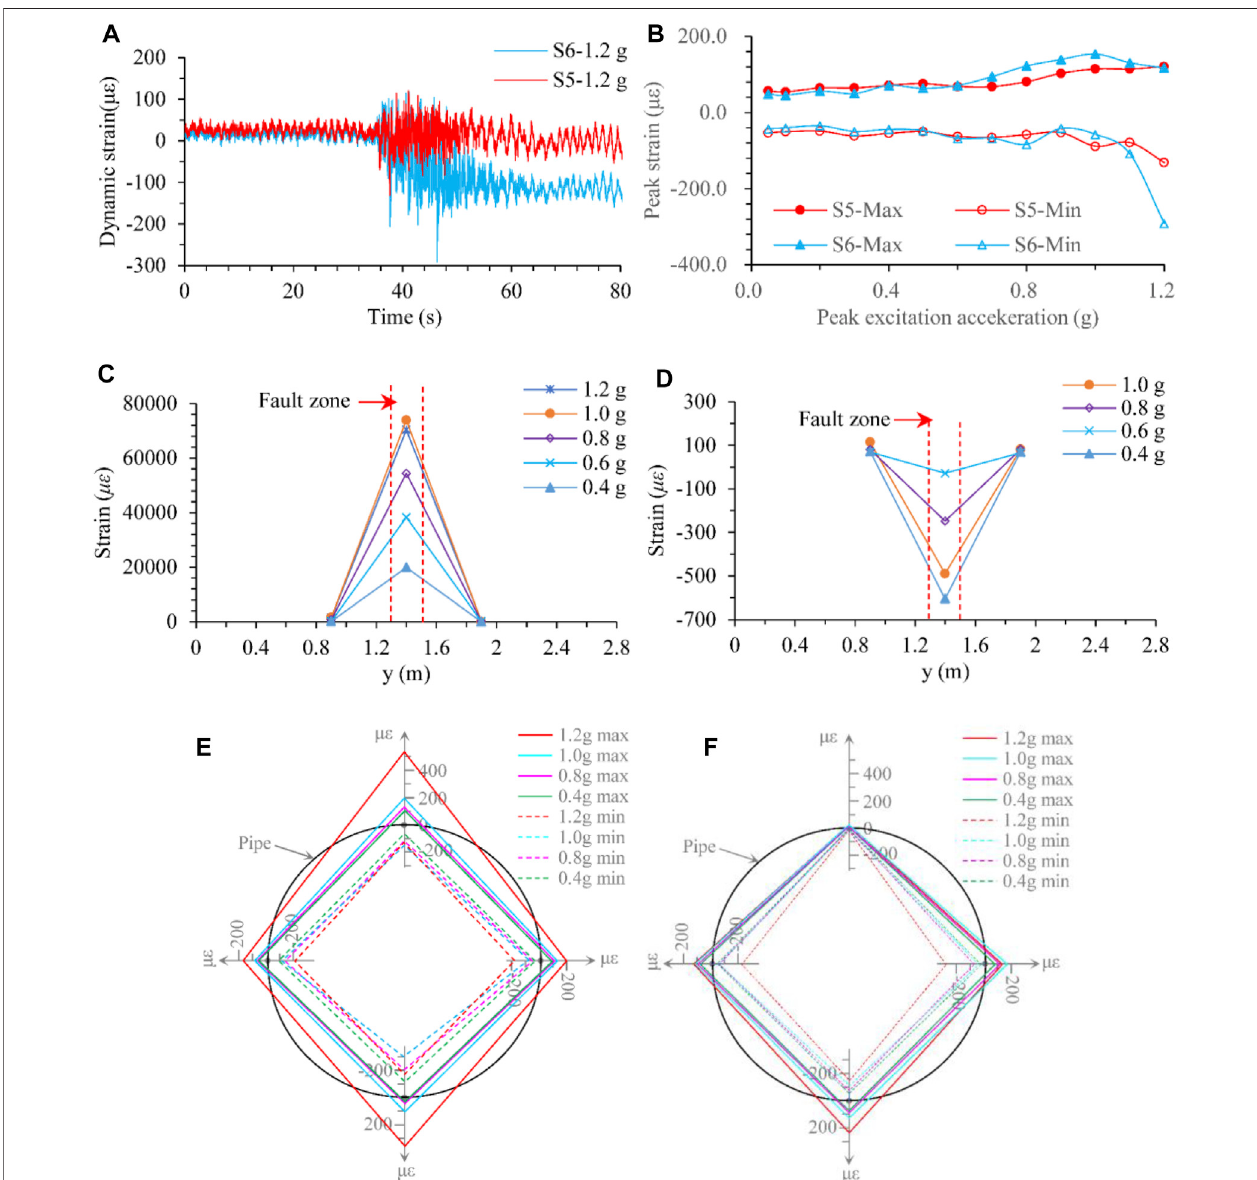
FIGURE 18 | Responsive dynamic strain of the pipe. (A) Strain time-history curves of typical monitoring points, (B) peak of responsive strain versus excitation acceleration, (C) peakaxialstrainvariationalongthepipebottom, (D) peakaxialstrainvariationalongthepipeside, (E) peakcircumferentialstrainalongthecross-section of y (cid:1) 1.4 m, (F) peak circumferential strain along the cross-section of y (cid:1) 0.9 m.